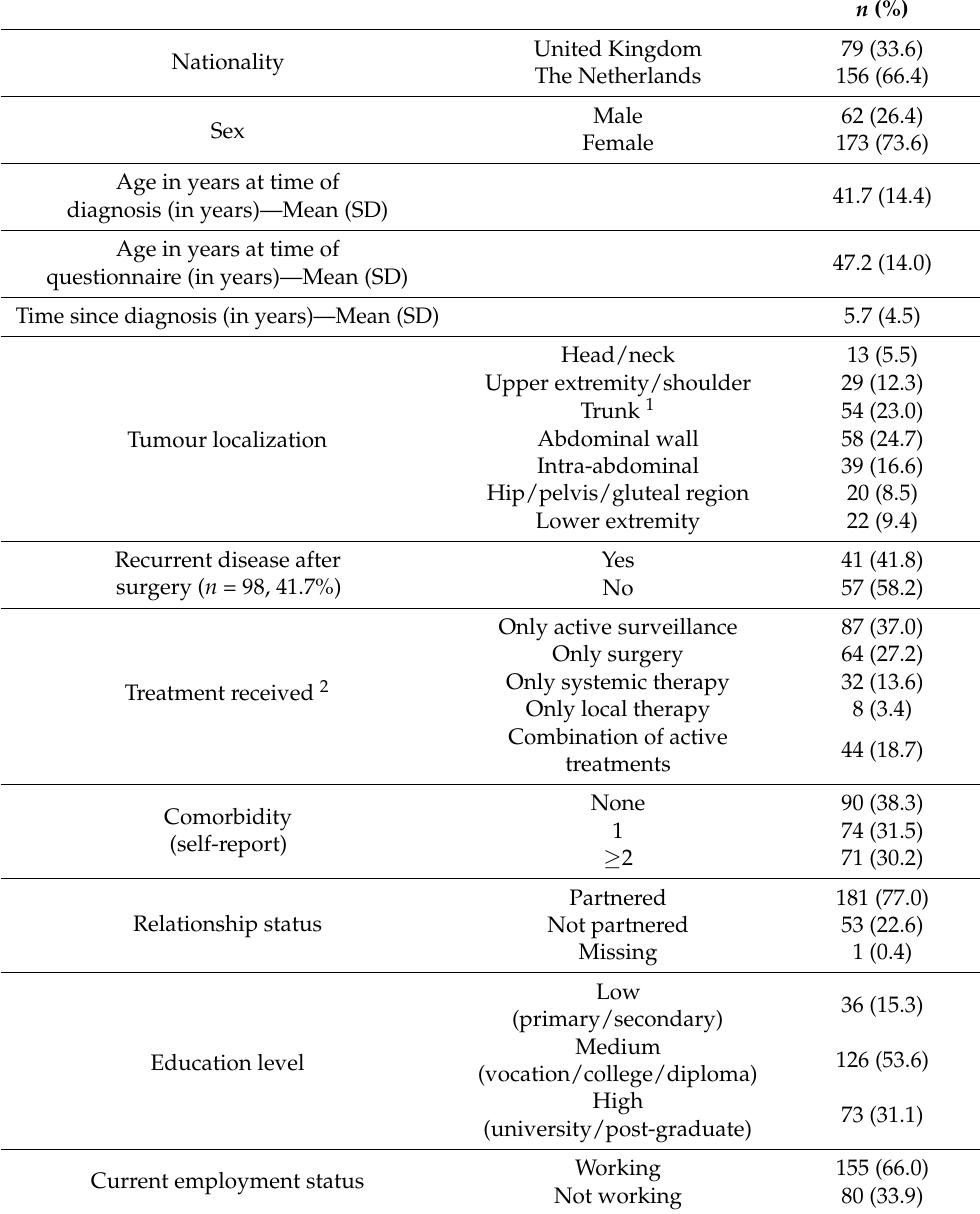
Table 1. Desmoid-type fibromatosis patient characteristics ( N =